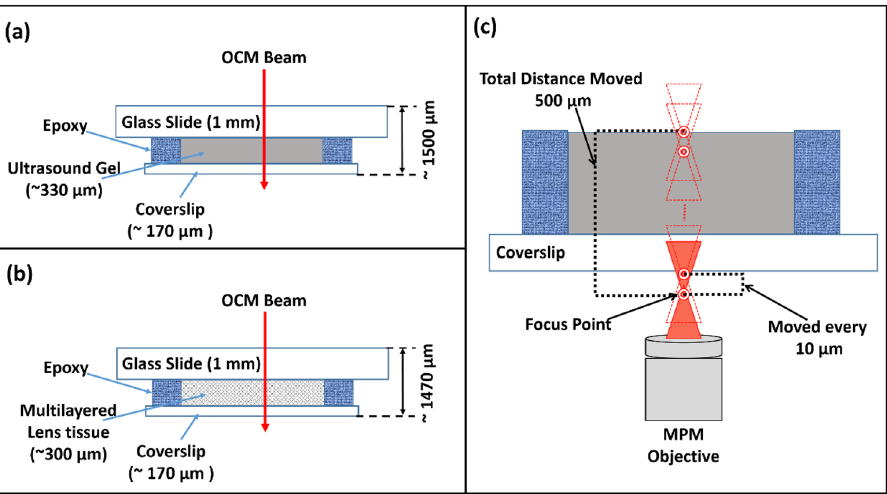
Figure 7. Schematic of phantom samples and the PD–PT OCM experimental protocol. ( a ) is the schematic cross-sectional representation of the simple phantom sample fabricated with ultrasound gel. ( b ) is a schematic cross-sectional representation of the complex network phantom sample fabricated with multilayered lens tissue. c is the figurative depiction of MPM objective positioning for the PD–PT OCM based methodology. Figures not drawn to